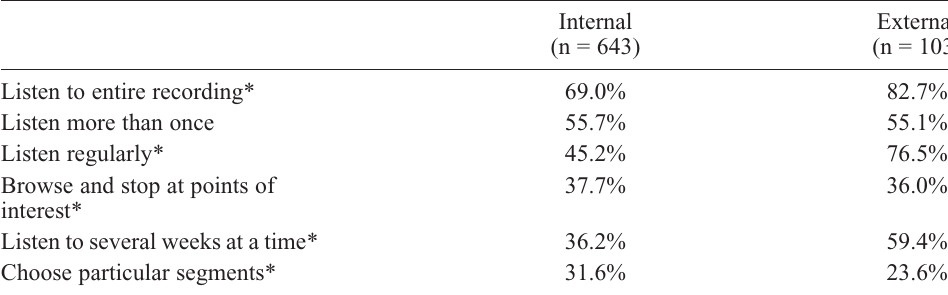
Table 3. Students’ usage patterns (%